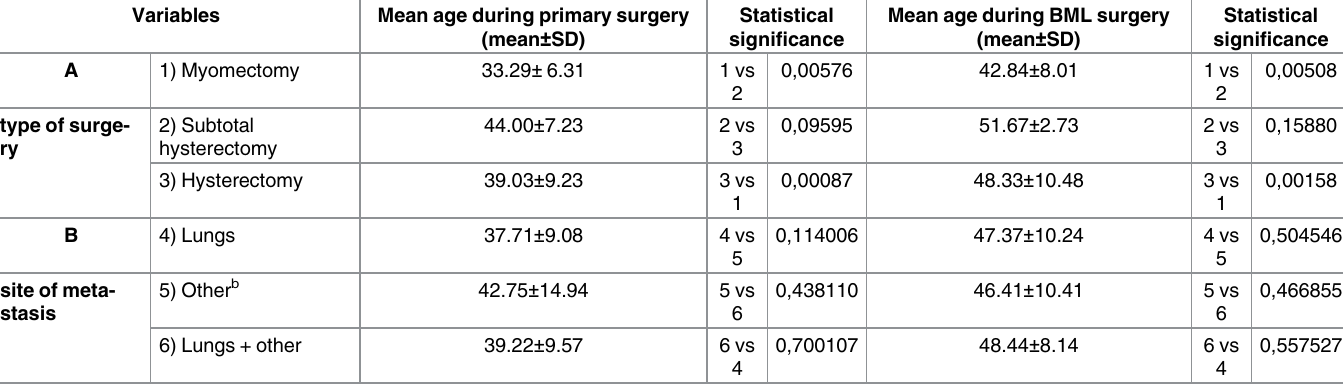
Table 1. Analysis of the relationship between selectedvariables.